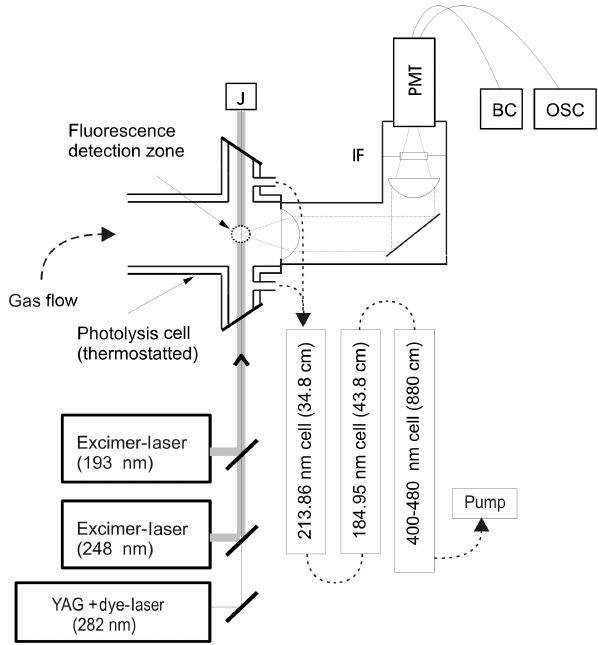
Figure 1. PLP–LIF set-up. MFC is mass flow controller, PMT is photomultiplier tube, J is Joule metre, BC is boxcar data acquisi- tion, OSC is oscilloscope, IF is interference filter (309 ± 5nm). Ca- pacitance manometers monitored the pressure in the reactor and the three optical absorption